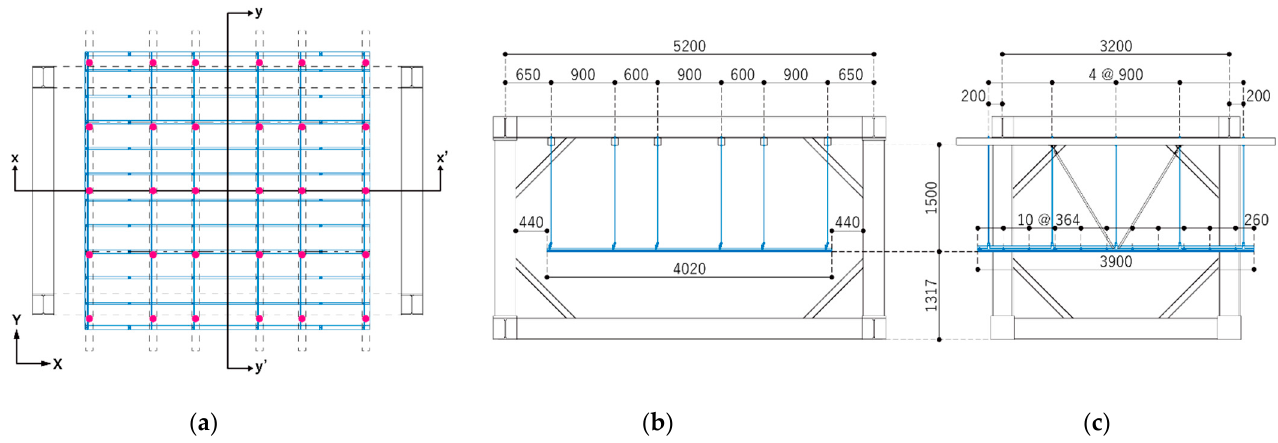
Figure 12. Schematic view of overall specimen: ( a ) Plan view; ( b ) cross-section view in X-direction; ( c ) cross-section view in Y-direction.